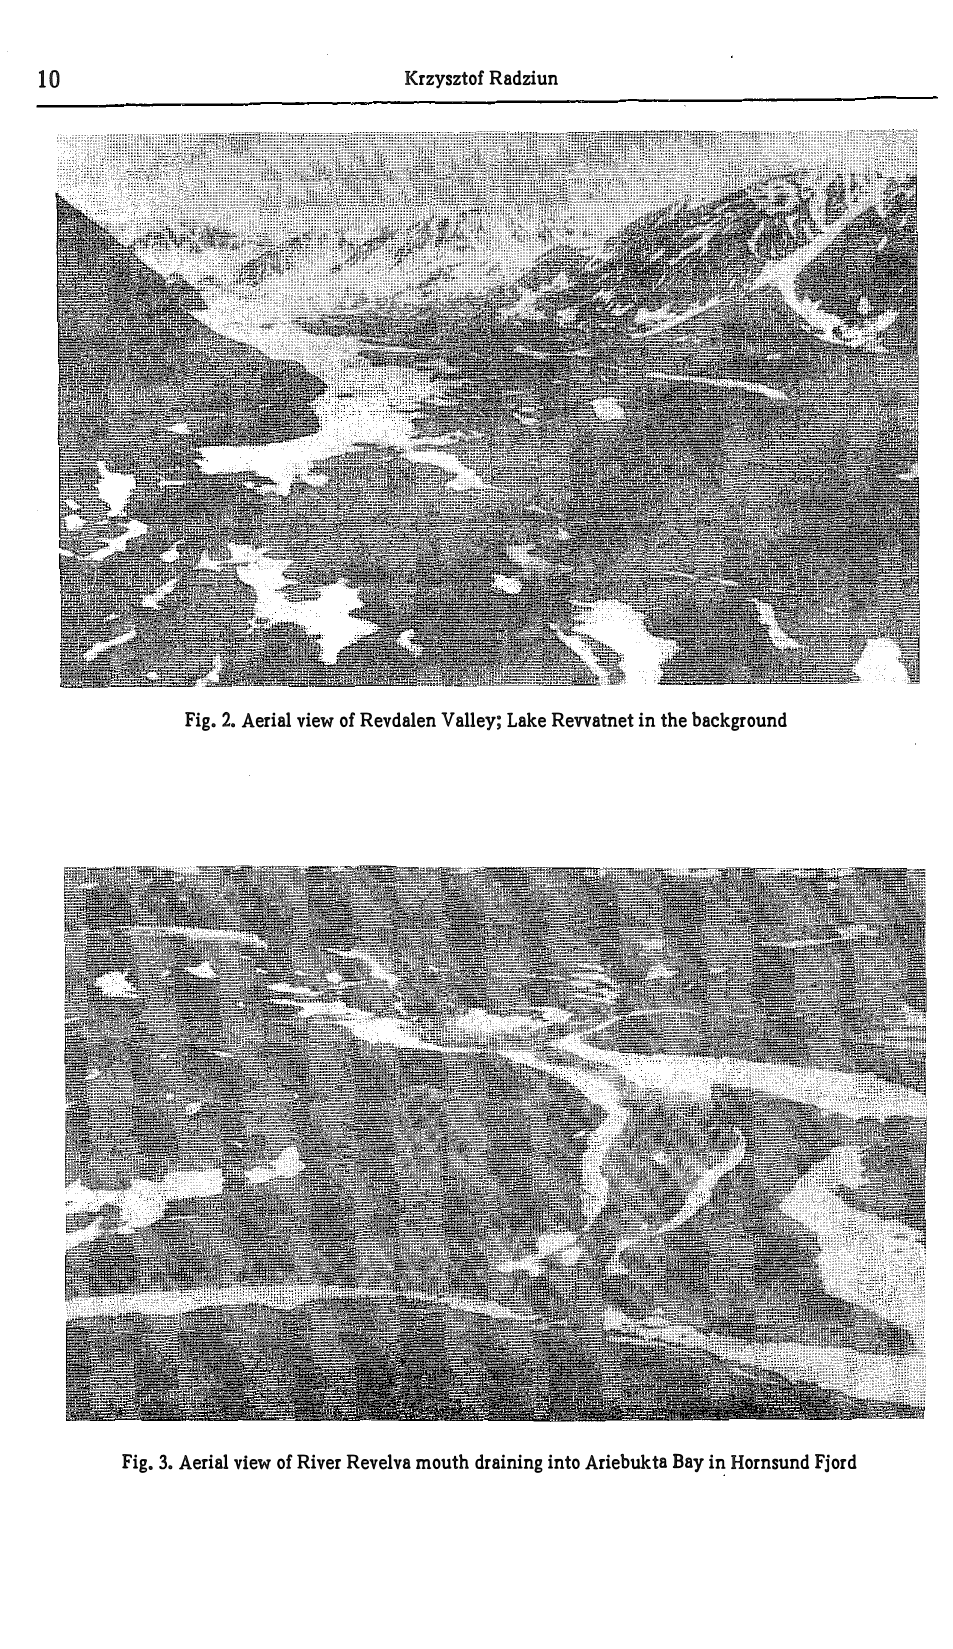
Fig. 3. Aerial view of River Revelva mouth draining into Ariebukta Bay in Hornsund